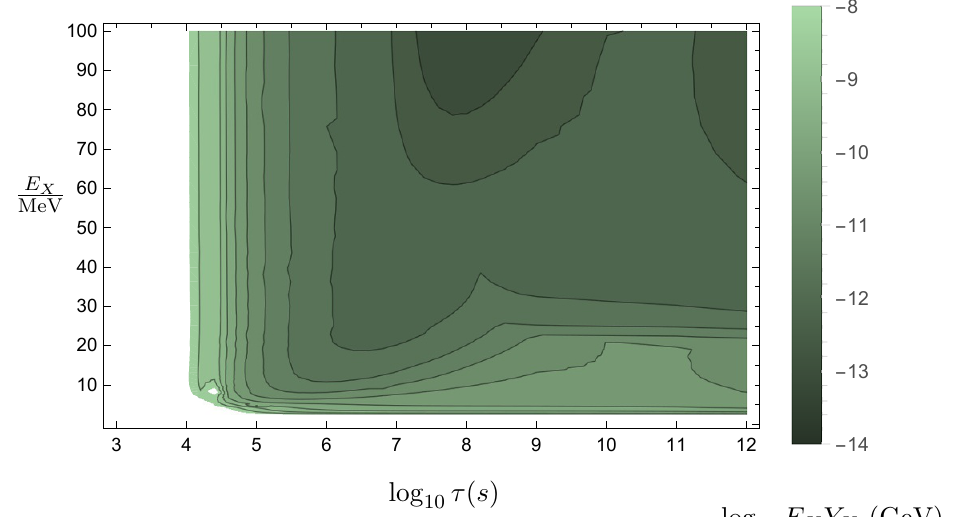
Figure 8 . Combined limits on E X Y X as a function of (cid:28) X and E X for the decay of a species X with lifetime (cid:28) X injecting an electron-positron pair each with energy E X , with FSR e(cid:11)ects